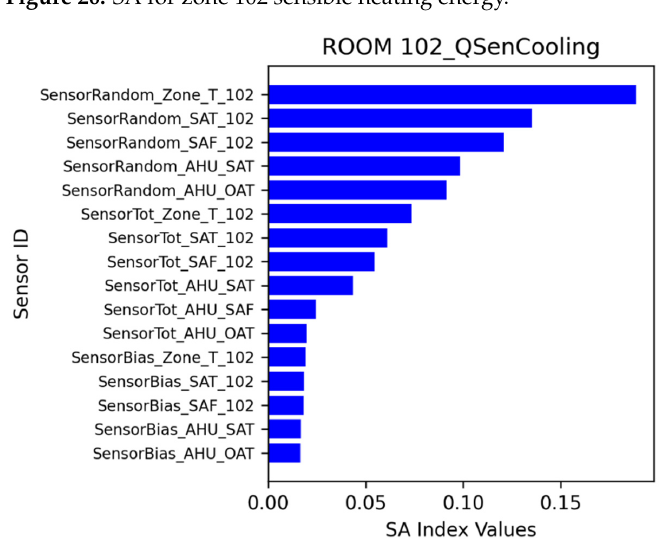
Figure 27. SA for zone 102 sensible cooling energy.